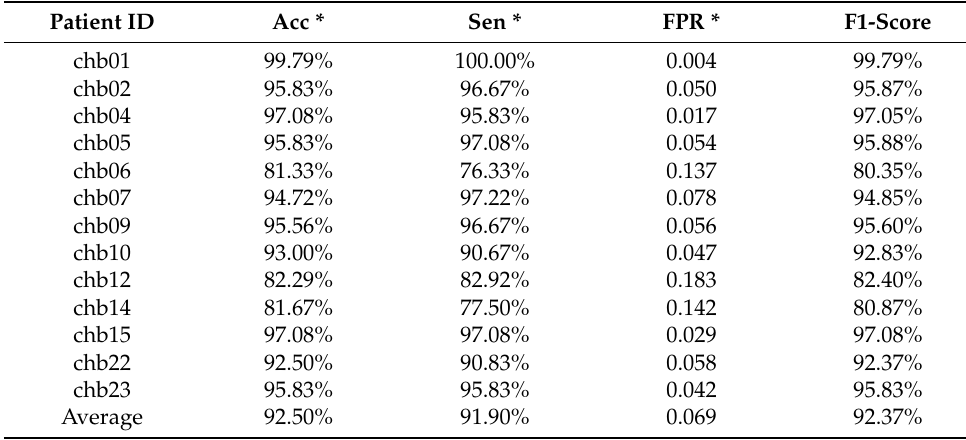
Table 3. Classification evaluation metrics (InT = 40 min).